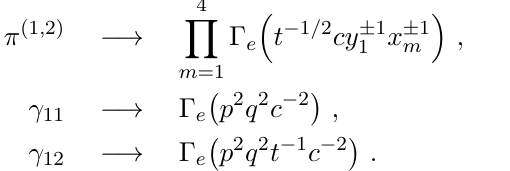
h i D (1) D (1) and [1 2]